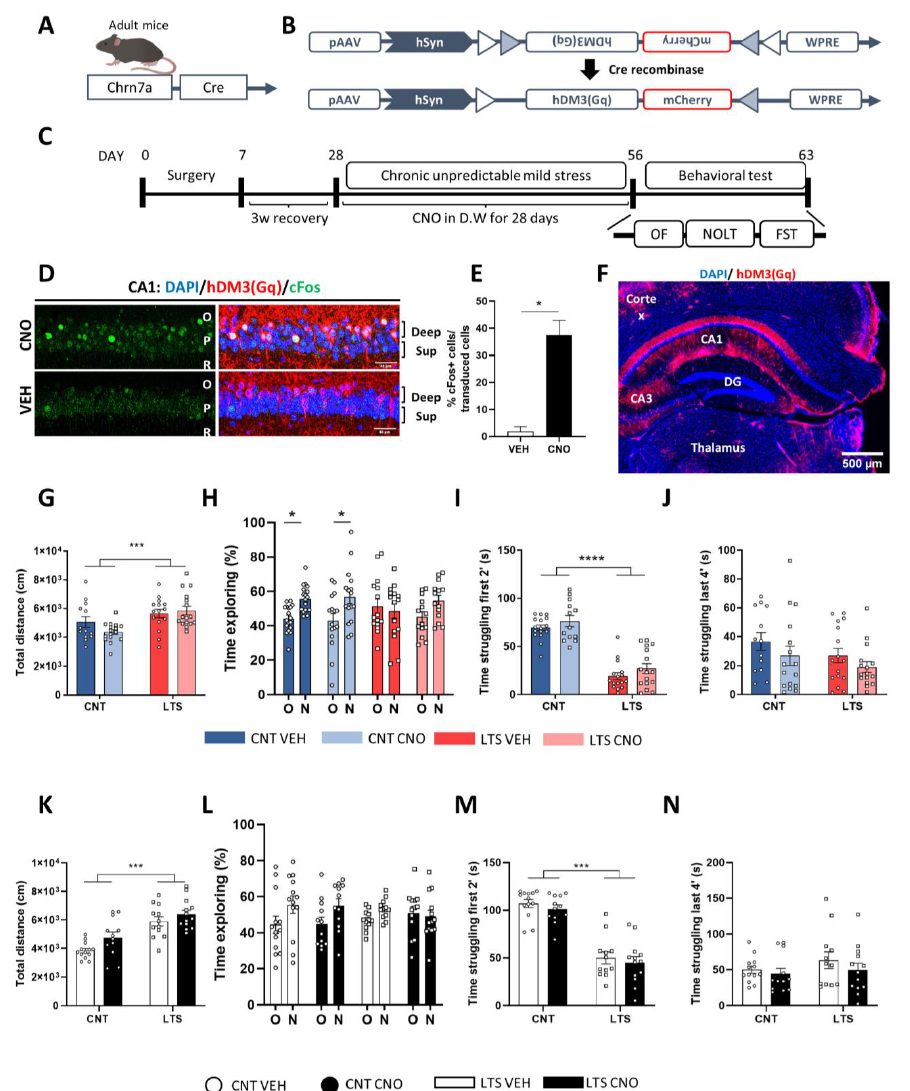
Figure 4. Effects of the chemogenetic activation of CA1 deep pyramidal neurons during CUMS. ( A ), Schematic illustration of the Chrn7a-Cre mouse model and of the AAV ( B ) used to express the activator DREADD (hDM3(Gq)) after Cre recombination. ( C ), Timeline of the experiment. Mice were injected with the vector shown in ( B ) and, after recovery, they were subjected to the CUMS protocol. During the stress protocol, mice received either CNO (1 mg/kg) or vehicle (VEH) solution in drinking water. Twenty-four h after the last stressor, mice were subjected to a battery of behavioral tests. ( D ), Representative image of CA1 showing cFos-positive cells (green) and viral transduction (mCherry, red) and cell nuclei (blue, DAPI). ( E ), Percentage of cFos+ cells (green) co- labelled with mCherry (red) in mice treated with VEH or CNO (unpaired t -test, t 17 = 2.83, p = 0.01). A representative global image ( F ) from ( D ) of viral transduction specifically in the hippocampal CA1. In the open field, locomotor activity ( G ) was monitored for 15 min. Two-way ANOVA, stress effect: F (1,56) = 13.23, p = 0.0006. ( H ), In the novel object location test, spatial memory was evaluated 24 h after a training trial as the percentage of total time spent exploring either the object placed at a new location ( N ) or the object placed at the old location ( O ). Two-way ANOVA, new location effect: F (1,122) = 8.64, p = 0.0039, N = 13–18 mice per condition. In the forced-swim test, the immobility time was evaluated during the first 2 min ( I ) and the last 4 min ( J ) of the 6 min trial in all groups. In